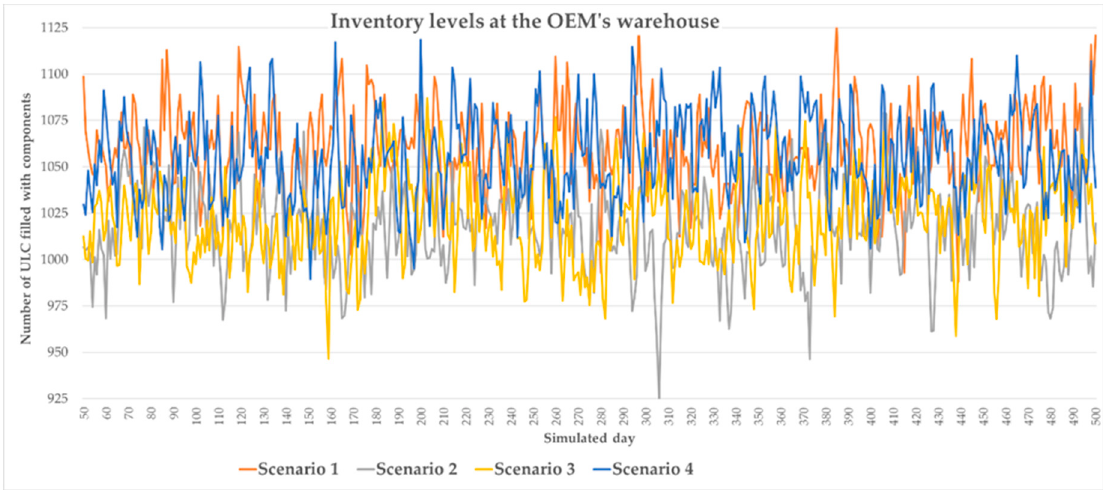
Figure 4. Comparison of scenarios 1–4 of original equipment manufacturers (OEM’s) warehouse inventory levels over simulated time.